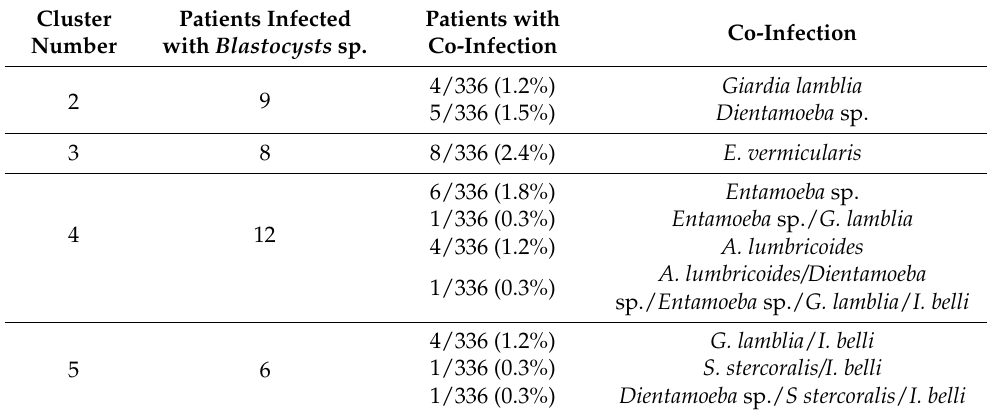
Table 5. Description of the number of patients with Blastocystosis and co-infections included in each cluster, except cluster 1 (only controls) and cluster 6 (patients carrying exclusively Blastocystis ). Cluster Patients Infected Number with Blastocysts